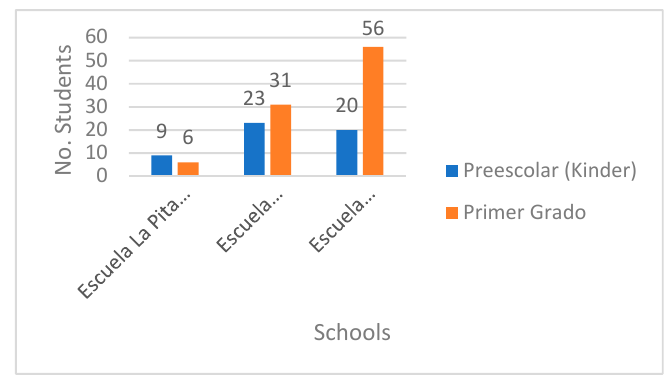
Figure 6. Number of students who participated in the pre-test.